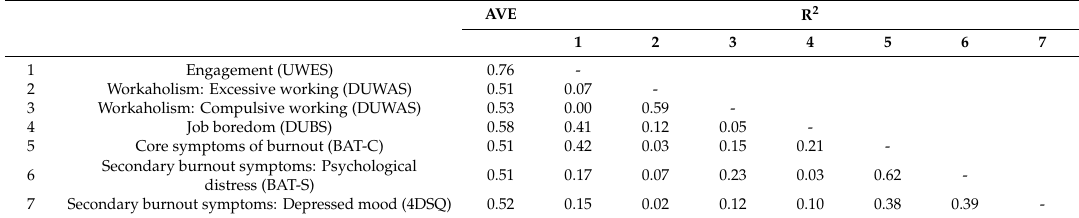
Table 3. Average Variance Extracted (AVE) scores and squared correlations for di ff erent